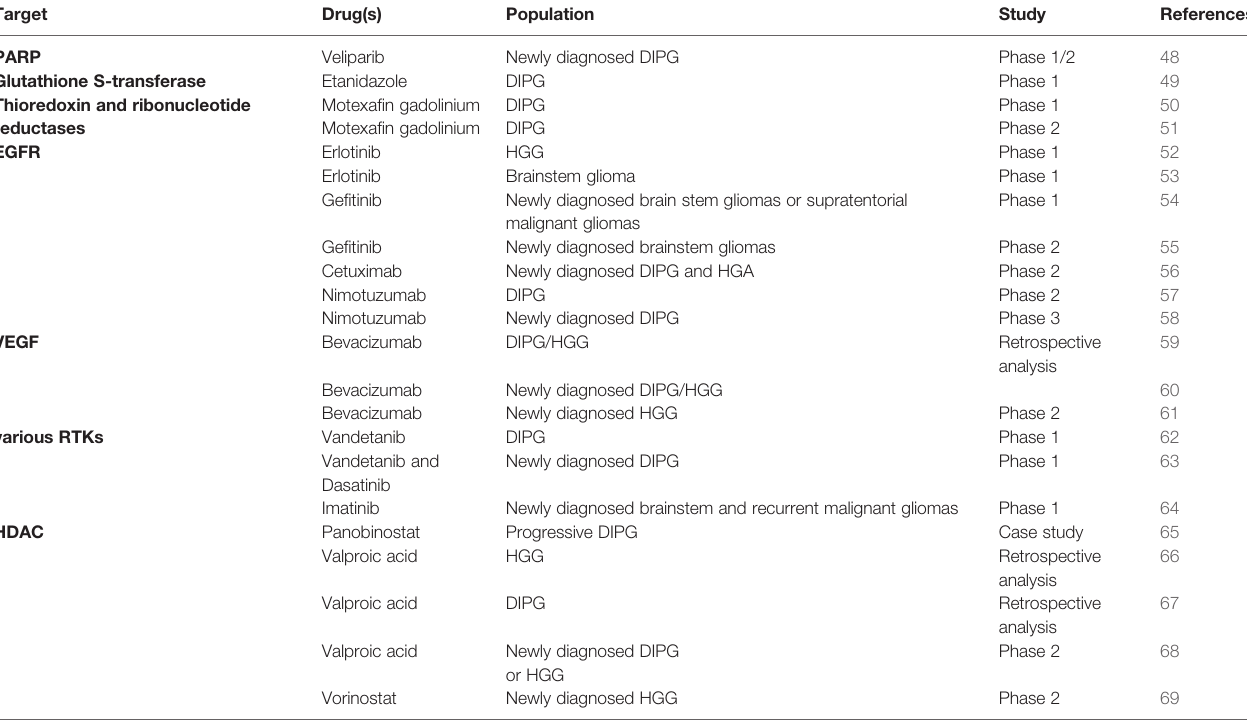
TABLE 2 | Overview clinical radiosensitization studies addressed in this review.